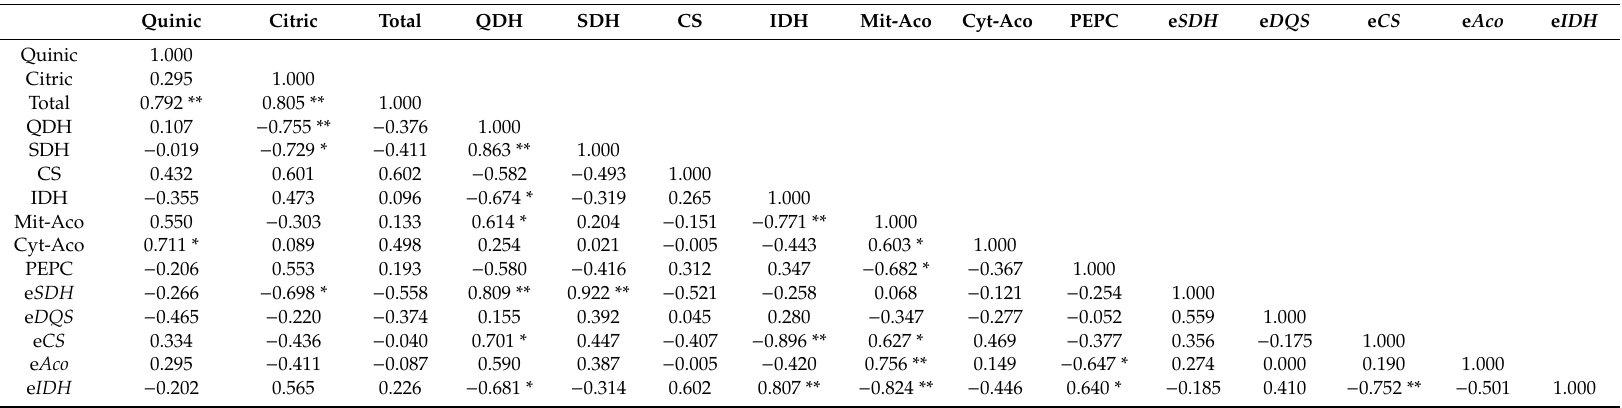
Table 1. The correlations in major organic acids content, enzyme activities and relative gene expression levels during developing fruit of A. eriantha ‘Ganmi 6’. Quinic Citric Total QDH SDH CS IDH Mit-Aco Cyt-Aco PEPC e SDH e DQS e CS e Aco e IDH Quinic 1.000 Citric 0.295 1.000 Total 0.792 ** 0.805 ** 1.000 QDH 0.107 − 0.319 0.265 1.000 Mit-Aco 0.550 − 0.303 0.133 0.614 * − 0.266 − 0.698 * − 0.558 0.809 ** 0.922 ** − 0.521 − 0.258 0.068 − 0.121 − 0.254 − 0.465 − 0.220 − 0.374 − 0.040 0.701 * 0.447 − 0.407 − 0.896 ** 0.627 * 0.469 − 0.377 0.356 − 0.175 1.000 e Aco 0.295 − 0.411 − 0.087 0.590 0.387 − 0.005 − 0.420 0.756 ** 0.149 − 0.647 * 0.274 0.000 0.190 1.000 e IDH − 0.202 0.565 0.226 − 0.681 * − 0.314 0.602 0.807 ** − 0.824 ** − 0.446 0.640 * − 0.185 0.410 − 0.752 ** − 0.501